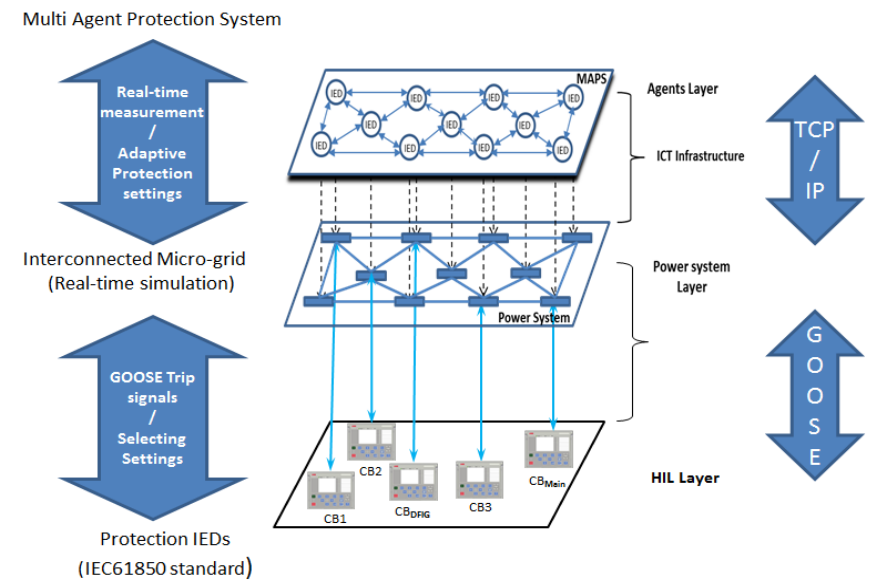
Figure 12. Architectural layers for developing co-simulation and HIL to simulate real-time MAPS.